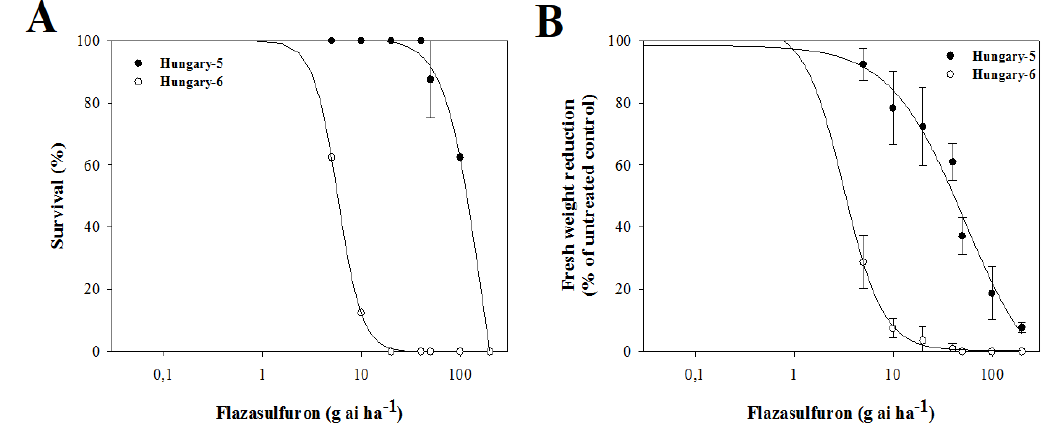
Figure 2. Flazasulfuron dose–response on ( A ) survival and ( B ) fresh weight reduction expressed as a percentage of the mean untreated control of the populations of C. canadensis from Spain (GR and GS) and Hungary (H1–H8). Symbols denote the mean ( n = 15) ± standard errors.